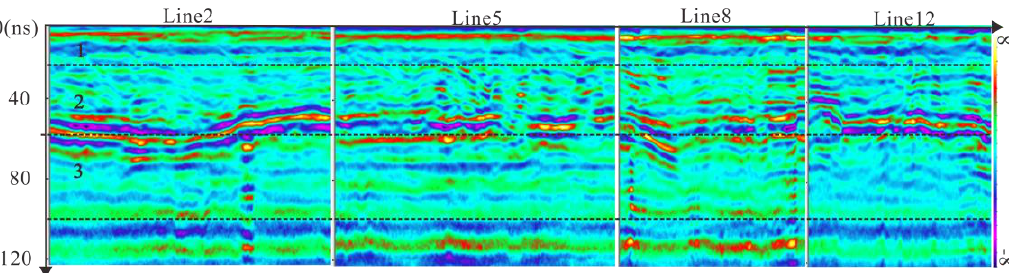
Figure 8. Relative wave impedance conversion profiles.